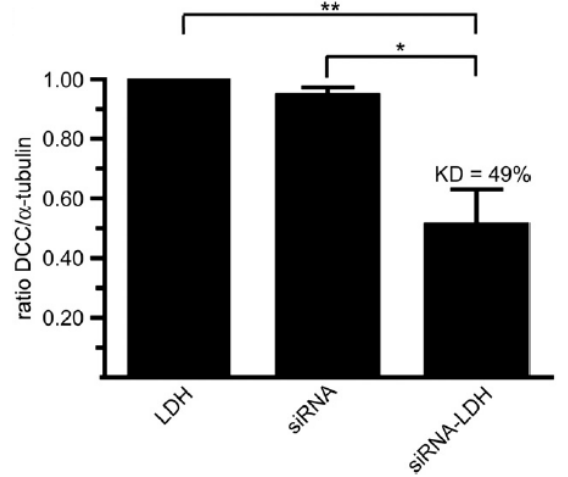
Figure 3. The knockdown profile of DCC by LDH mediated delivery of siRNA to neurons. (Reproduced with permission from Wong et al.